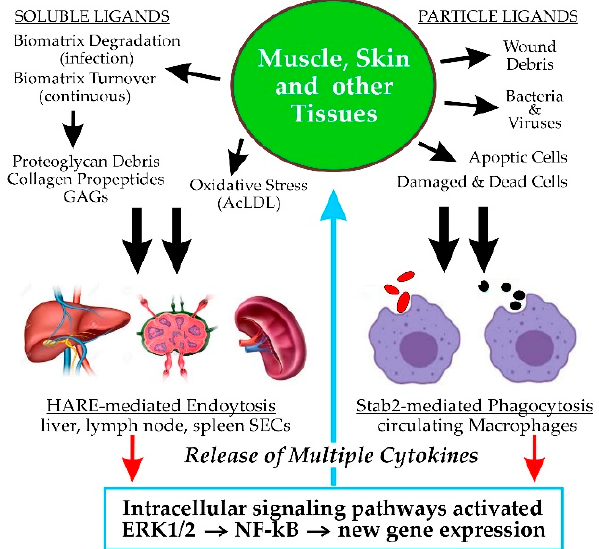
Figure 9. A HARE/Stab2 Tissue-Stress Sensor System. The scheme [84] shows parallel systemic loops in which intracellular signaling is stimulated by HARE-mediated endocytosis (left) of four key soluble ligands (HA, Hep, DS and AcLDL) or by Stab2-mediated phagocytosis of particulate debris or cells (right). These signaling cascades activate genes regulated by NF- κ B promoters (red arrows) stimulating synthesis and secretion of pro-inflammatory cytokines such as Transforming Growth Factor- β (TGF β ) [18,50] that can direct new tissue responses (blue arrows) to the physiologic or homeostatic threats [85–87]. Soluble ligands shed from body tissues during infection, necrosis or biomatrix turnover are endocytosed by fixed SECs in the liver, lymph nodes and spleen (left). Particle phagocytosis by circulating macrophages (right) removes and destroys apoptotic red or white blood cells (red ovals), wound debris and bacterial cells (black ovals).